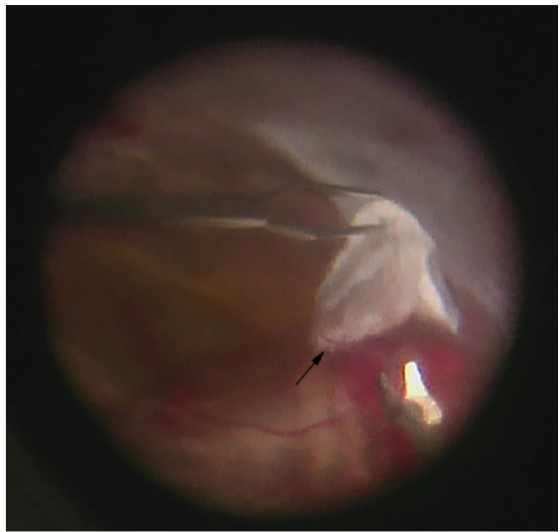
Figure 4. Fibrovascular membrane of a tractional retinal detachment (TRD). A combination of forceps and scissors is used to delaminate and remove the membrane from the retinal surface without injury to the retina. Remnant neovascularization (arrow) can be seen at the base of the white fibrous membrane as the majority has regressed following preoperative treatment with bevacizumab. (Intraoperative image courtesy of Siva S.R. Iyer,